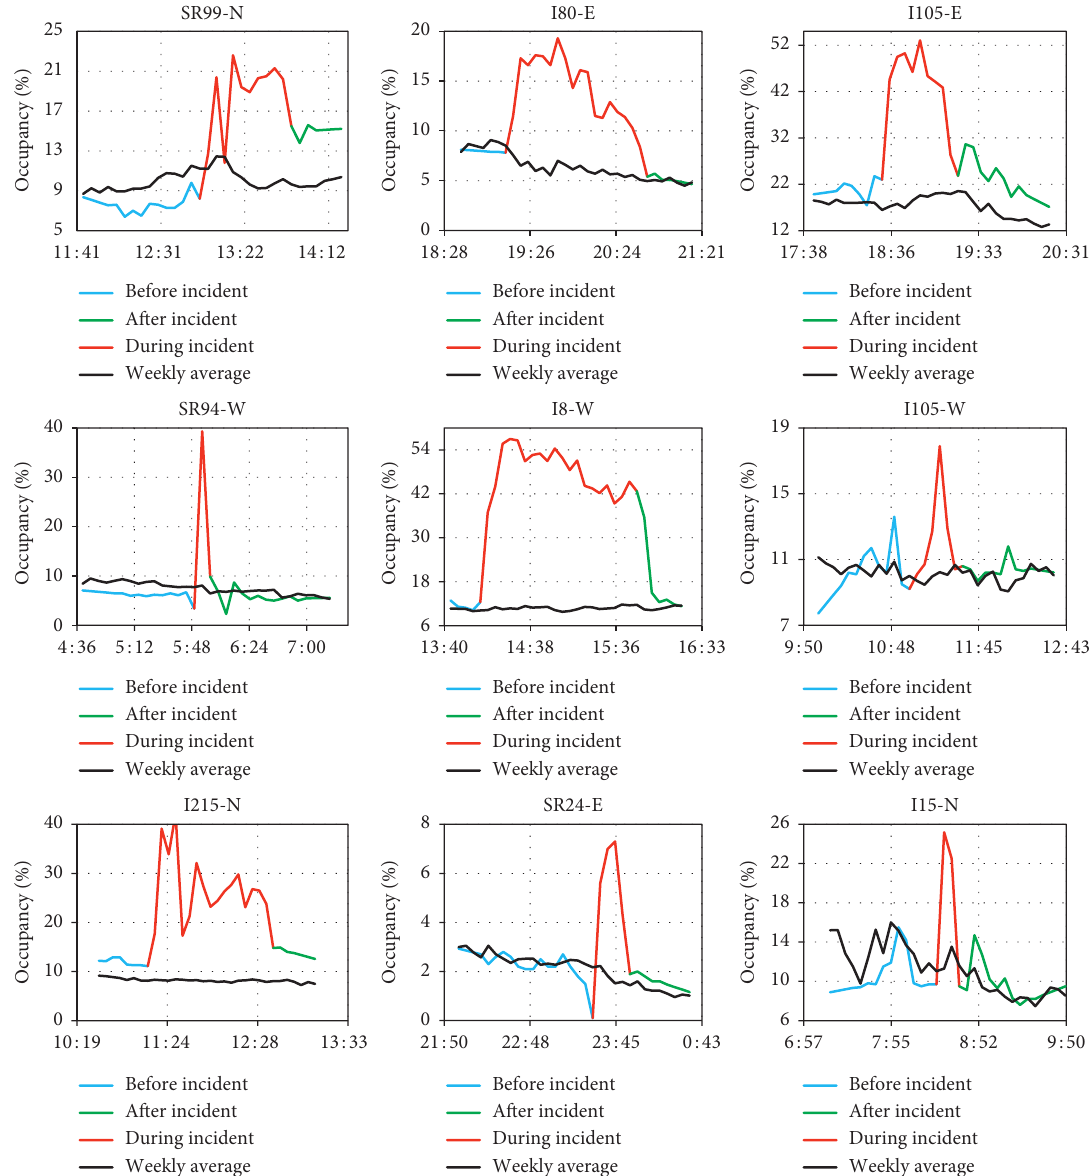
Figure 4: The comparison of pre-incident, during the incident and post-incident occupancies with the weekly average occupancy. Table 1: Comparison of postincident speed and occupancy with the weekly average values.